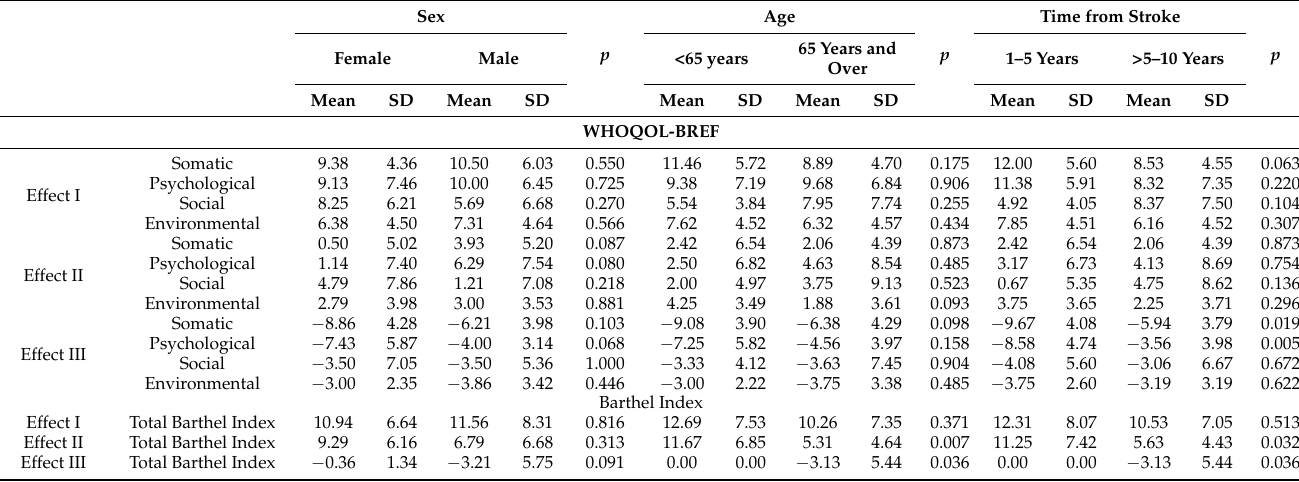
Table 3. The effects of the rehabilitation program relative to the age, sex and time from stroke onset of